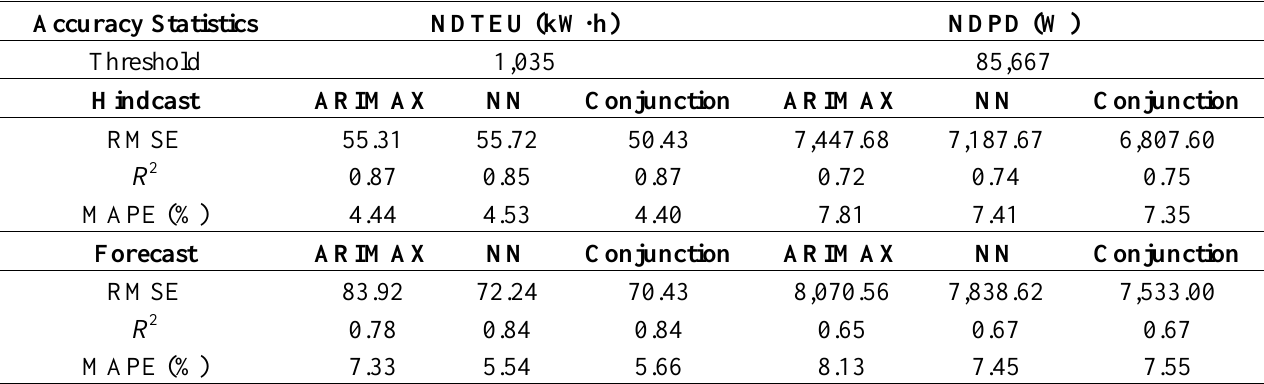
Table 6. Phase 3’s hybrid model statistics.